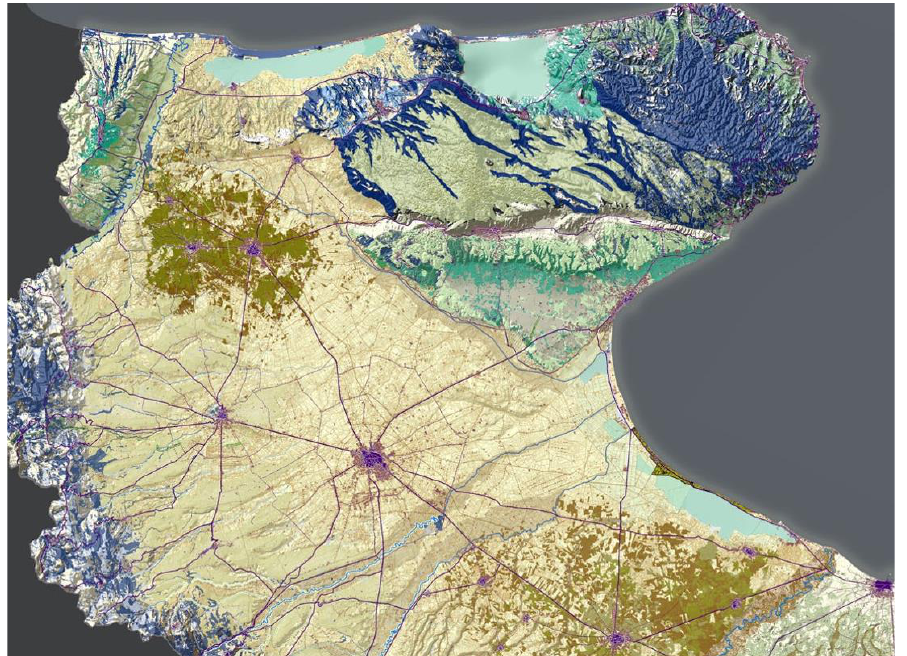
Figure 3. Landscape plan of Puglia, landscape morphology of the region.